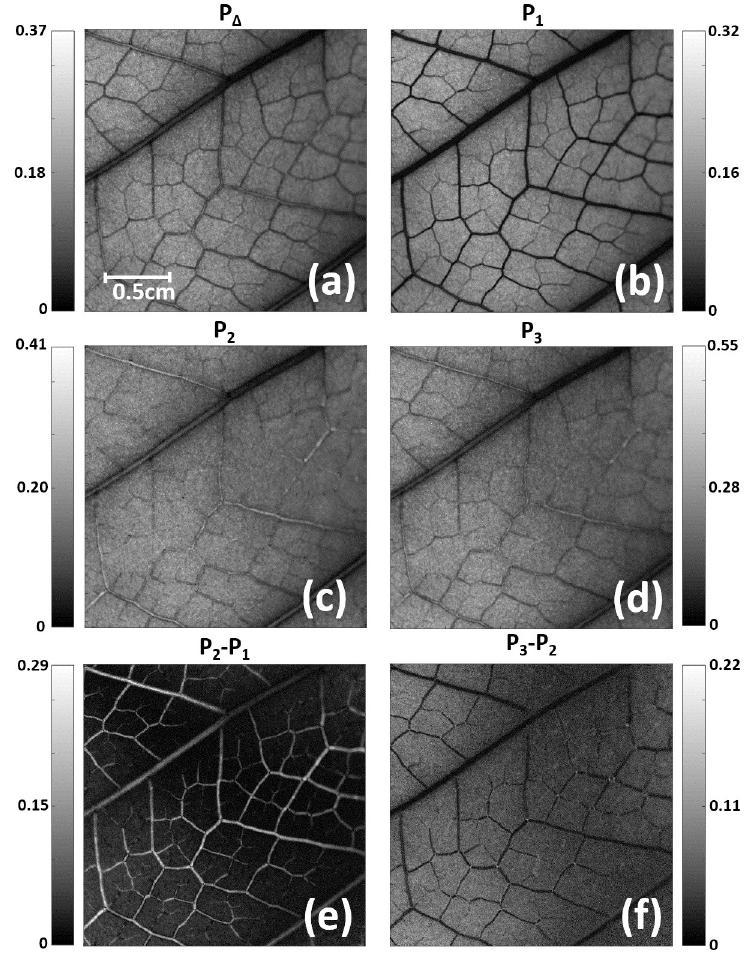
Fig 7. Hedera maroccana (Sample A) images obtained by using different depolarizing based indicators: (a) Depolarization Index P Δ ; (b)-(d) Indices of Polarimetric Purity (IPPs), P combining different IPP channels: (e) P 2 - P 1 ; and (f) P 3 - P 2 .